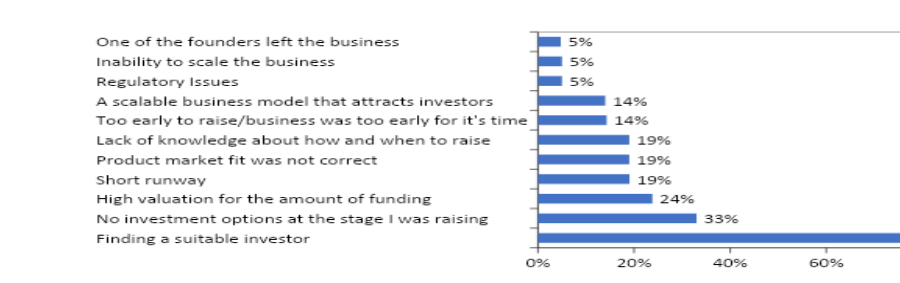
Figure 17: Pitfalls in Raising Capital by Startups